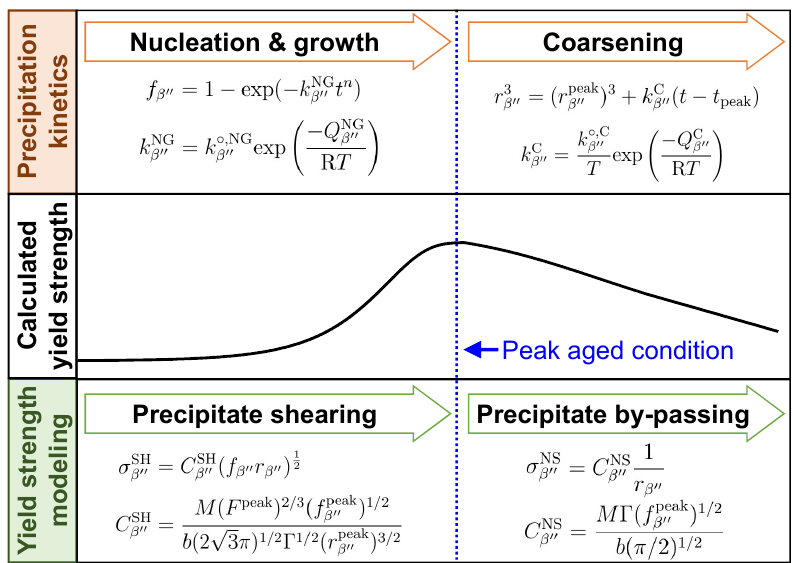
Figure 1. The structure of the yield strength model proposed in the present study.